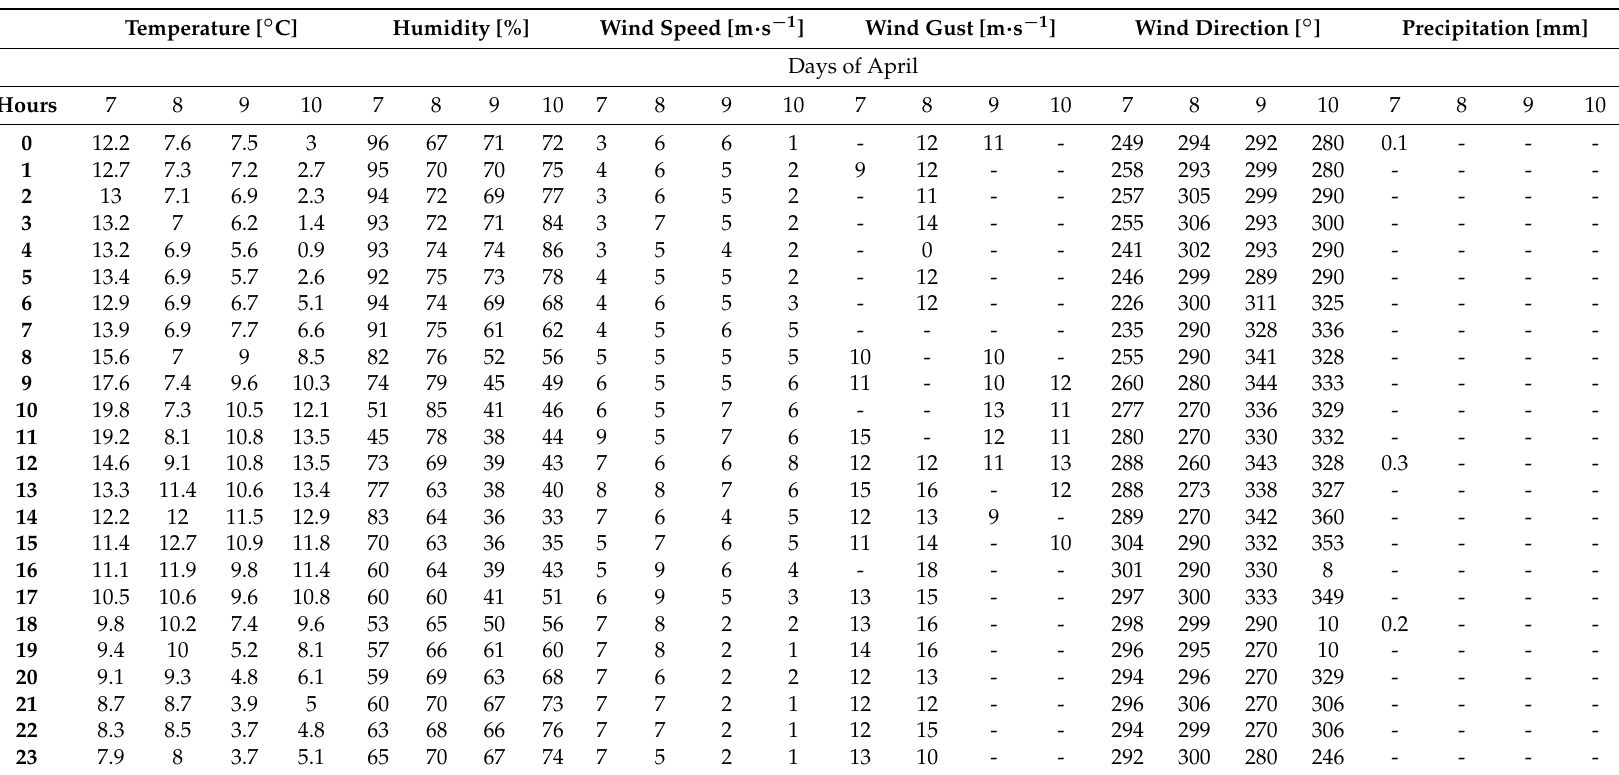
Table 1. Meteorological data for days with a dust storm for IMWM Piła station. For precipitation, data is available every 6 h. Temperature [ ◦